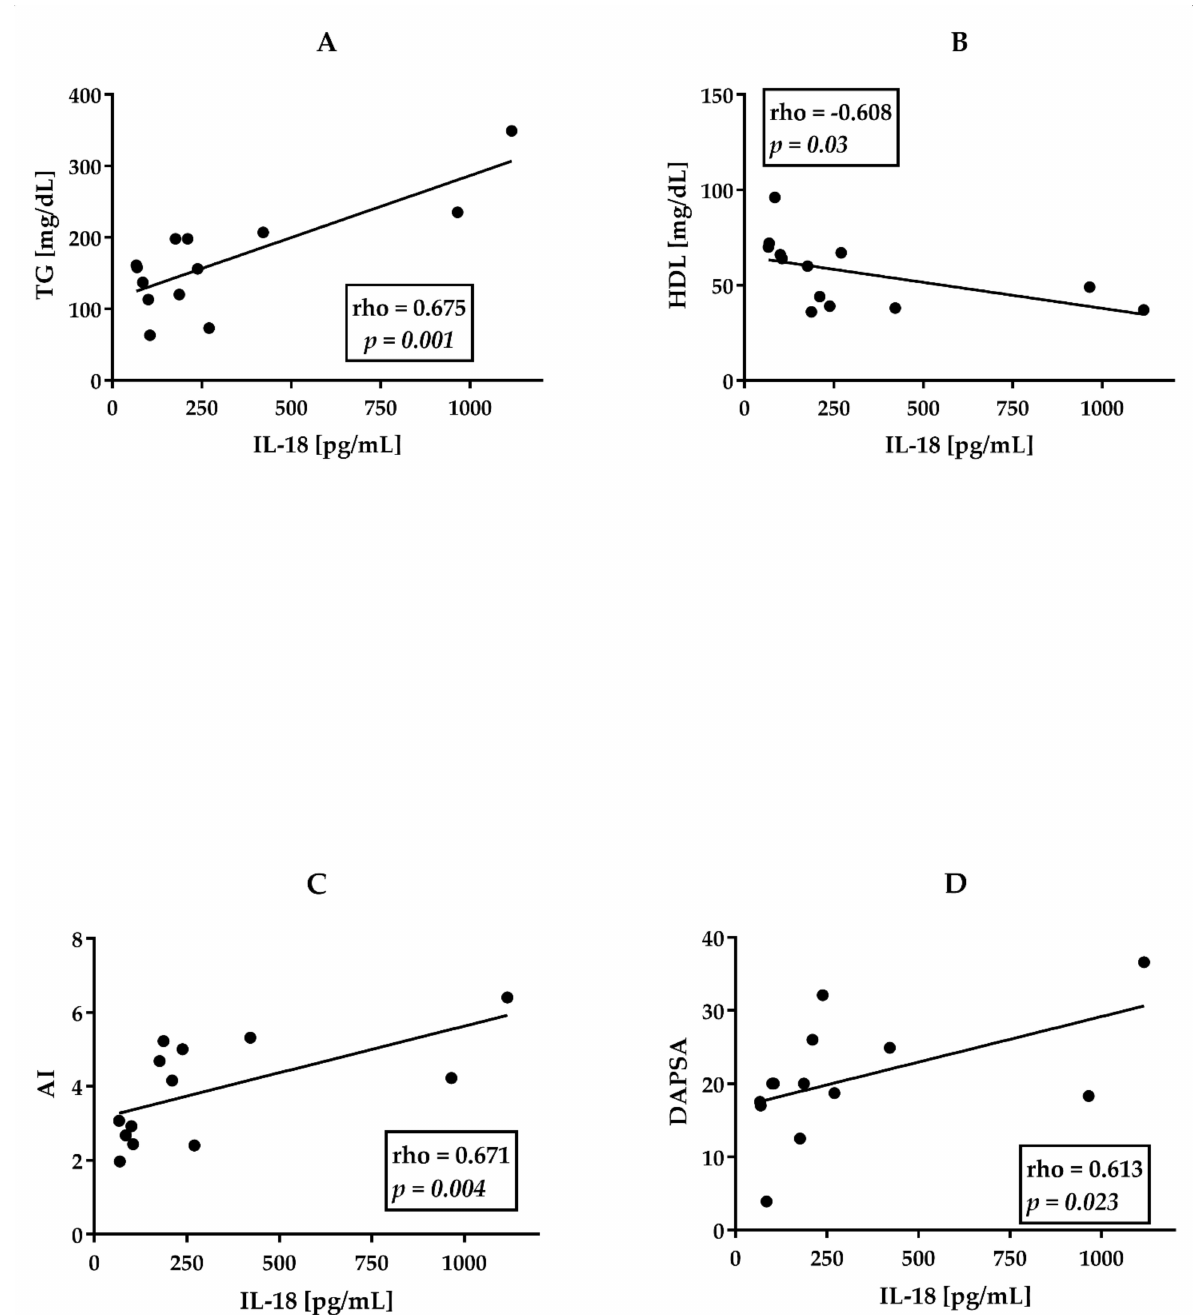
Figure 2. Correlations between IL-18 and lipid profile and DAPSA in patients with PsA and ischemic heart disease ( n = 14). ( A )TG—triglycerides. ( B ) HDL—High-Density Cholesterol. ( C ) AI—atherogenic index. ( D ) DAPSA. All correlations were analyzed using Spearman’s rank test. Rho—Spearman’s rank correlation coefficient. p —value for null hypothesis for Spearman’s rank